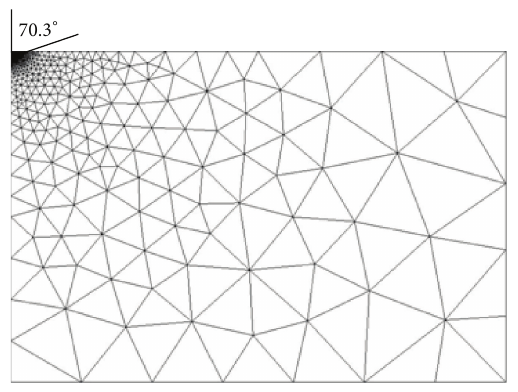
Figure 12: FEM model.